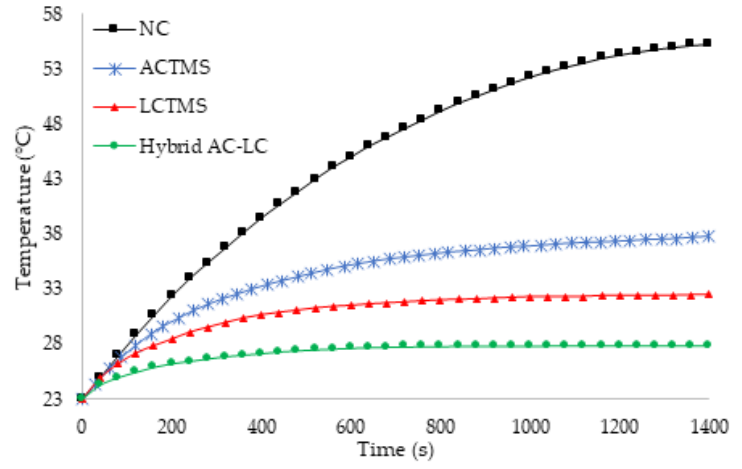
Figure 21. Comparison of various systems for LiCs in high power applications; NC: natural convection, ACTMS: air cooled TMS, LCTMS: liquid cooled TMS, hybrid AC-LC: hybrid air cooling combined with a liquid cooling system [41].